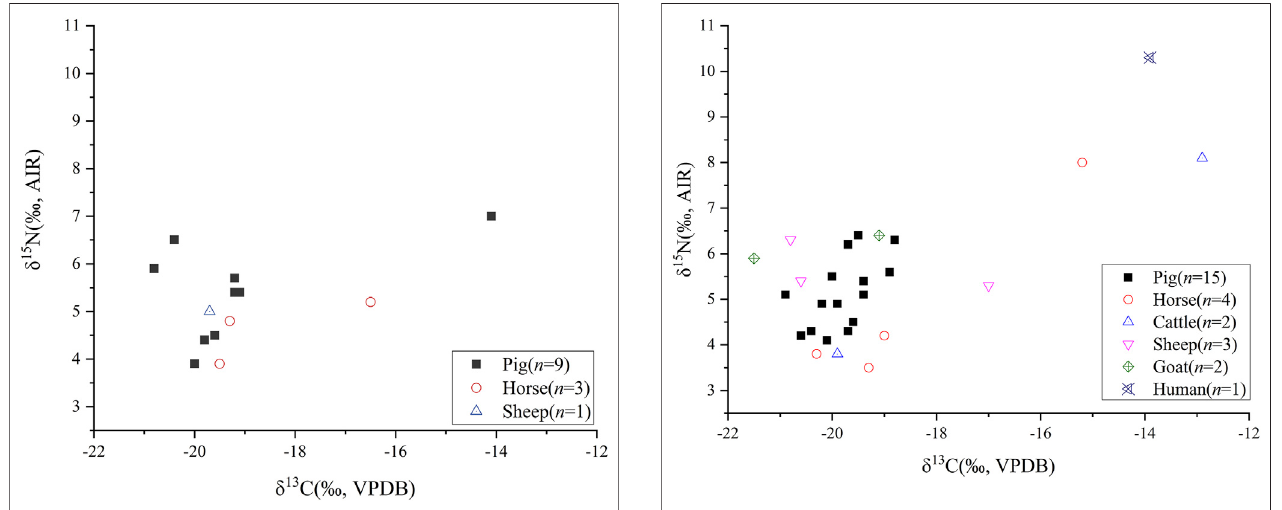
FIGURE 4 | Scatter plot of the stable isotopes of animal bones from the Changshan site during the Bronze Age.